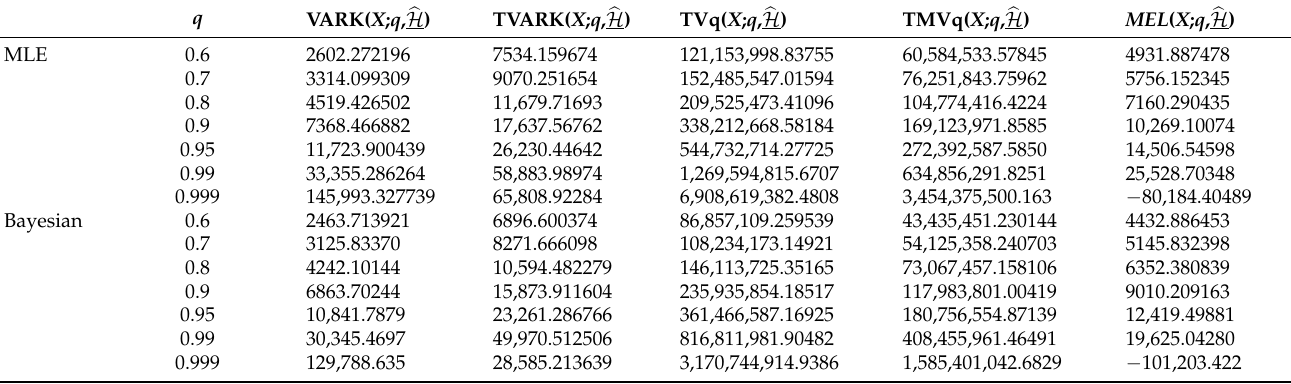
Figure 9. The ACF ( left graph ), and the partial ACF ( right graph ) for the insurance-claims data. Table 13. The results of the EGRRP under insurance-claims data.